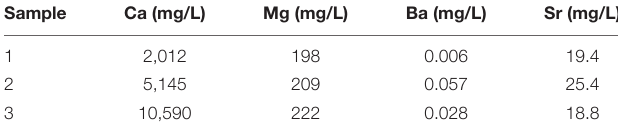
TABLE 1 | The scale-forming ion analysis of the formation of brine sample.